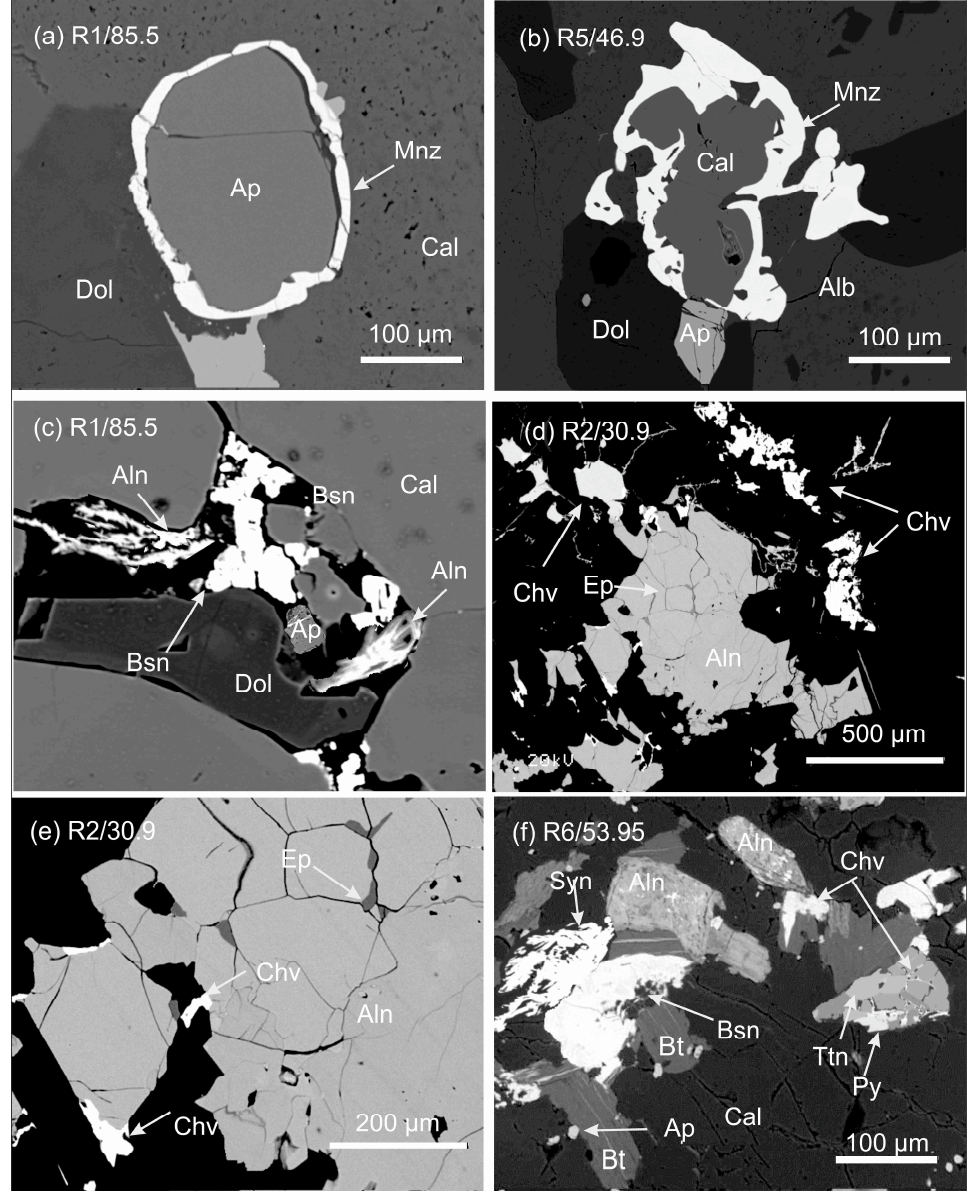
Figure 7. Back-scattered electron (BSE) images of REE-minerals from Kortejärvi and Laivajoki carbonatite samples; ( a , b ) Monazite (Mnz) associated with apatite (Ap), calcite (Cal), dolomite (Dol) and albite (Alb); ( c ) Bastnäsite (Bsn) and acicular allanite (Aln) in association with fluorcarbonate minerals; ( d , e ) Large allanite crystal within fractures filled by epidote (Ep), and the rim of allanite is replaced by secondary chevkinite (Chv; bright zones); ( f ) Acicular synchysite (Syn), chevkinite (Chv) and bastnäsite in association with allanite, biotite (Bt) and calcite. Chevnikite also fills fractures in titanite (Ttn) and pyrite (Py).